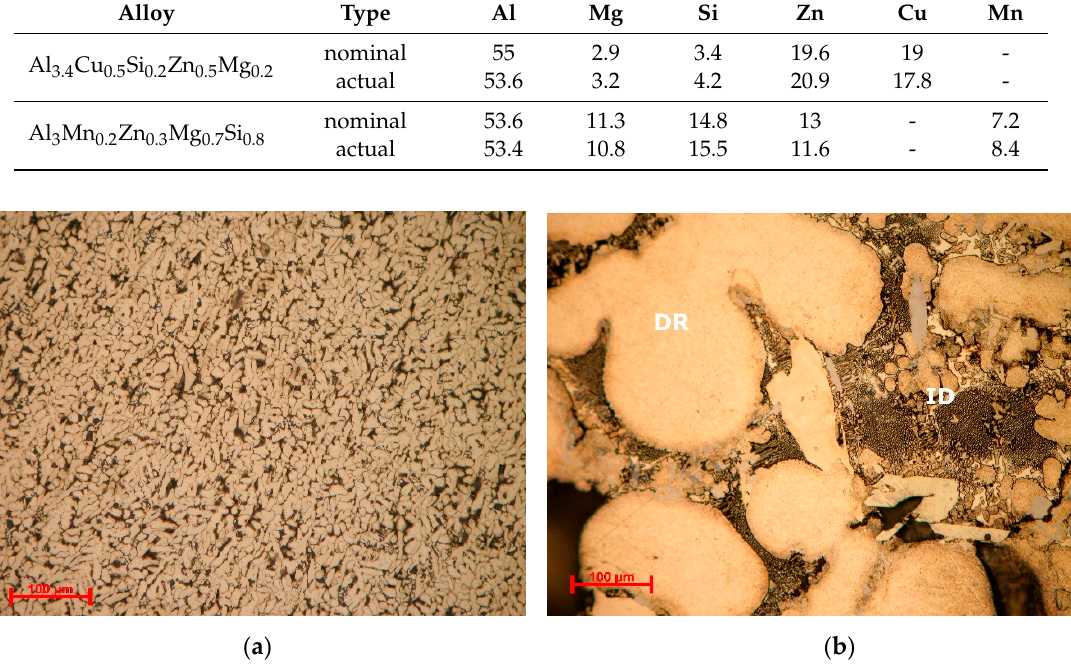
Figure 13. Optical micrographs of ( a ) as-cast and ( b ) annealed cast Al 3 Mn 0.2 Zn 0.3 Mg 0.7 Si 0.8 alloy. DR— dendritic area; ID—interdendritic area. Figure 14. SEM images of ( a ) as-cast and ( b ) annealed cast Al 3.4 Cu 0.5 Si 0.2 Zn 0.5 Mg 0.2 alloy. DR—dendritic area; ID—interdendritic area; ID1,2,3, and 4—interdendritic phases (Table 4).